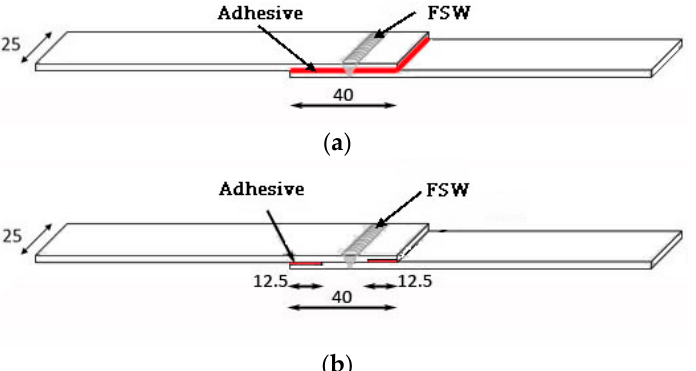
Figure3. Schematicillustrationsofthejoints(valuesinmm), madeusingtwomethods: ( a )Weld-through Figure 3. Schematic illustrations of the joints (values in mm), made using two methods: ( a ) Weld- and ( b ) through and ( b ) flow-in.